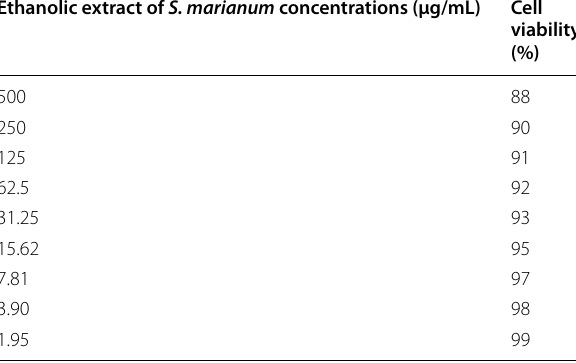
Table 2 Toxicity of ethanolic extract of S. marianum using MTT